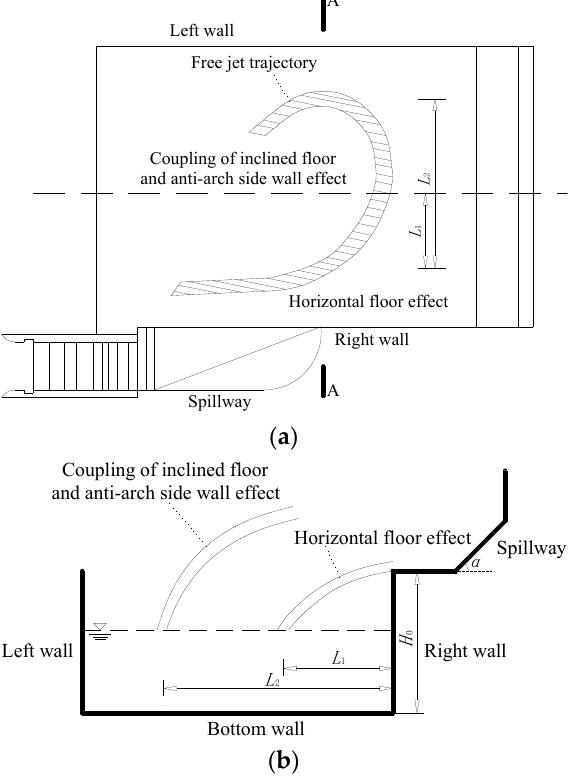
Figure 7. Sketch of free jet flow deflecting from the streamwise-lateral discharge spillway: ( a ) plane view; ( b ) lateral view (A–A).